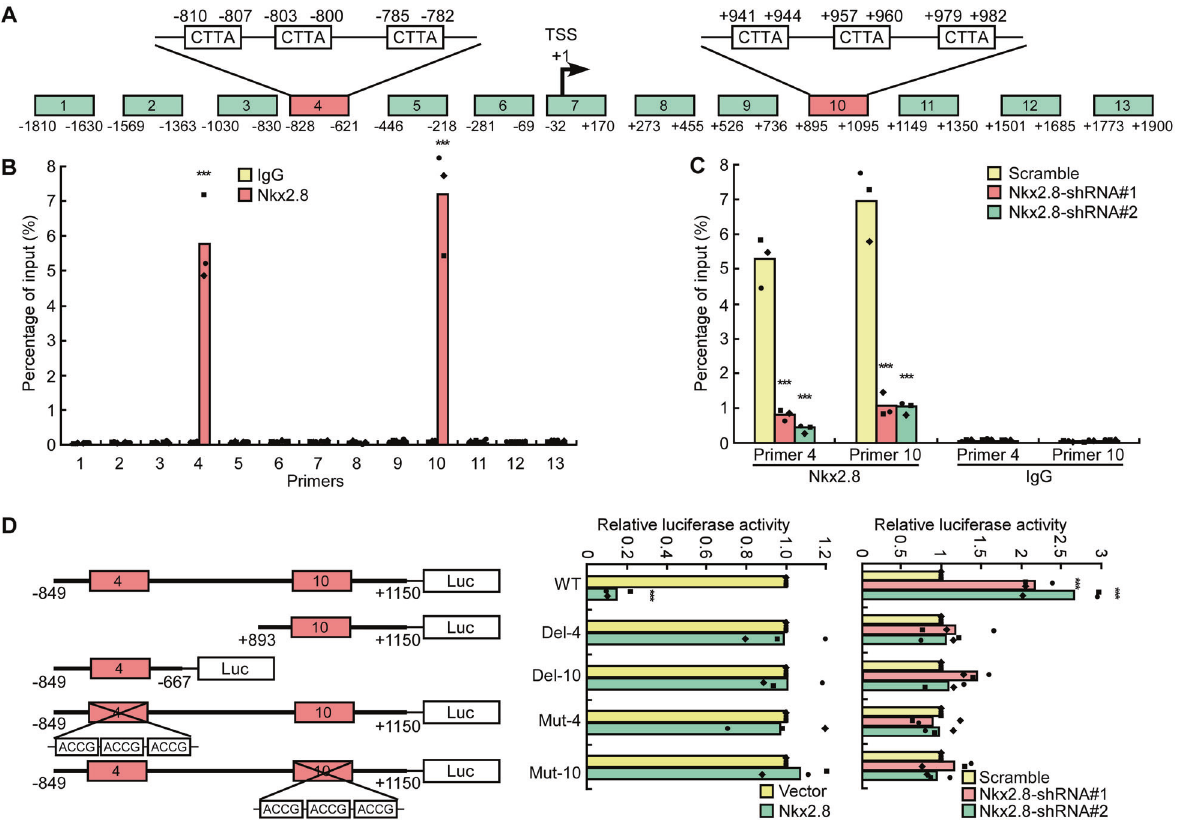
Fig. 5 Nkx2.8 binds to the MDR1 promoter locus and transcriptionally represses MDR1 . A Schematic representation of the promoter region of MDR1 . Precipitated DNA was ampli fi ed in a PCR assay using primers speci fi c for regions 1-13. TSS: Transcriptional start site. B ChIP analysis was performed using an anti-Nkx2.8 antibody or anti-IgG antibody to identify Nkx2.8 binding sites on the MDR1 promoter in 5637 cells (mean ± SD). C ChIP analysis of Nkx2.8 binding ef fi ciency in 5637 cells expressing the scrambled shRNA or Nkx2.8 shRNA (mean ± SD). D Transactivities of Nkx2.8 on serial MDR1 promoter fragments as indicated in 5637 cells (mean ± SD). ** p < 0.001 (two-tailed t test, n =